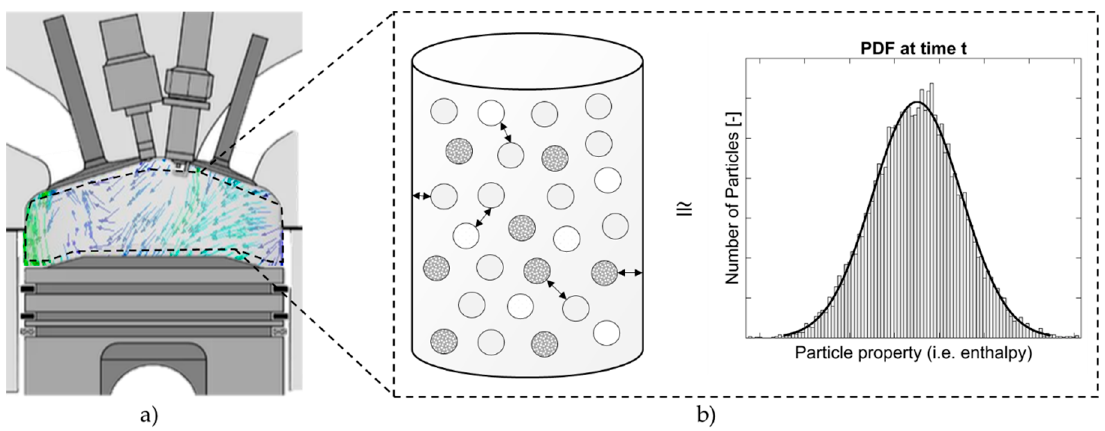
Figure 1. Schematic visualization of the Stochastic Reactor Model (SRM) concept; ( a ) engine physical space; ( b ) 0-D particles in the SRM computational space and an exemplary distribution of particle properties at a given time-step t.